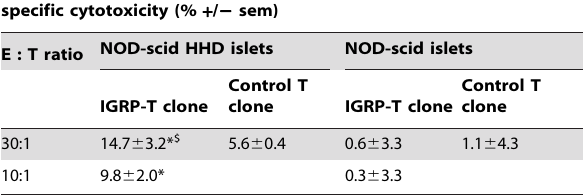
Table 1. IGRP-specific T-cells lyse HLA-A2-positive islets in-